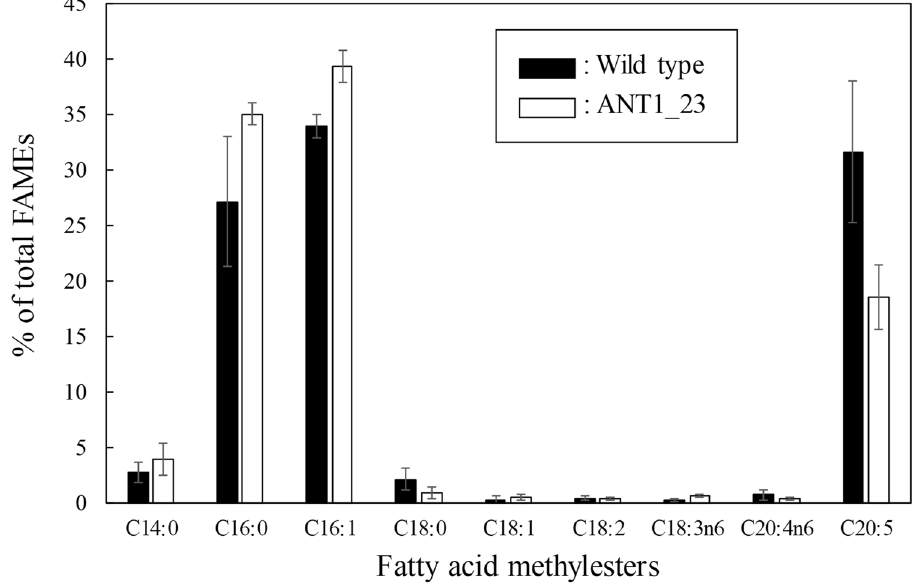
Figure 4. Fatty acid compositions of F. solaris wild type and transformant (ANT1_23) at 72 h cultured under nutrient-replete condition. Values are means ± SD of three independent